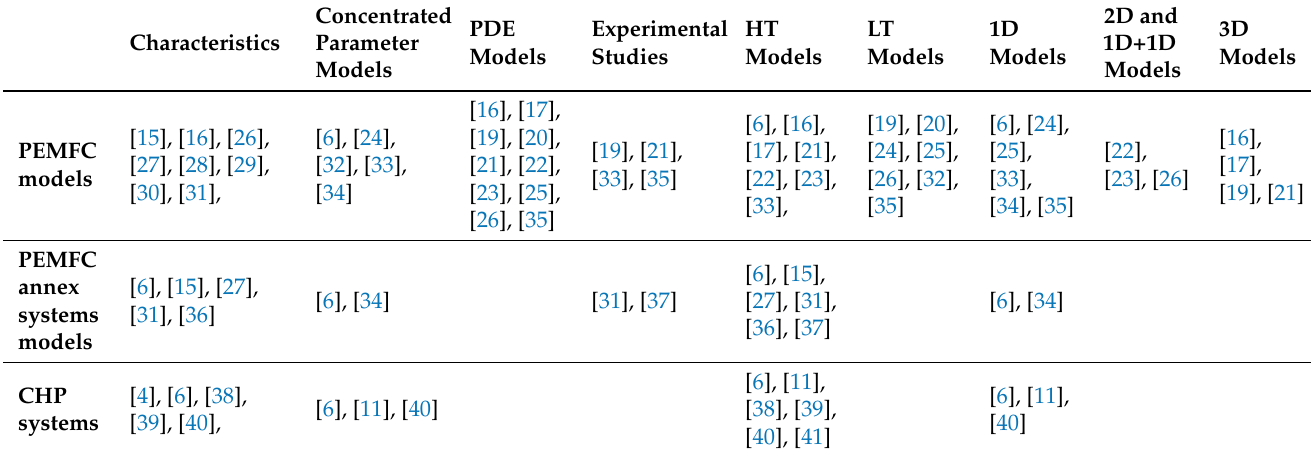
Table 2. PEMFC models and